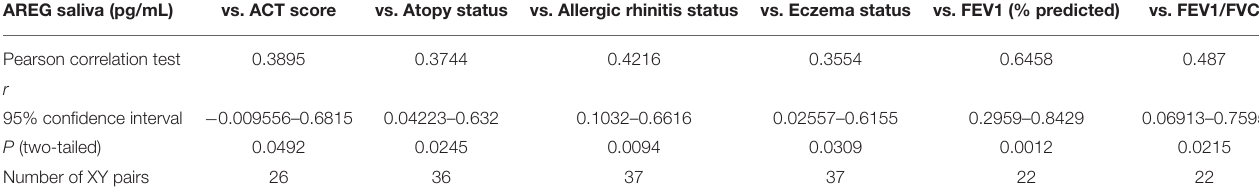
TABLE 5 | Correlation between saliva AREG concentrations, and the cohort demographics and laboratory tests. AREG saliva (pg/mL)